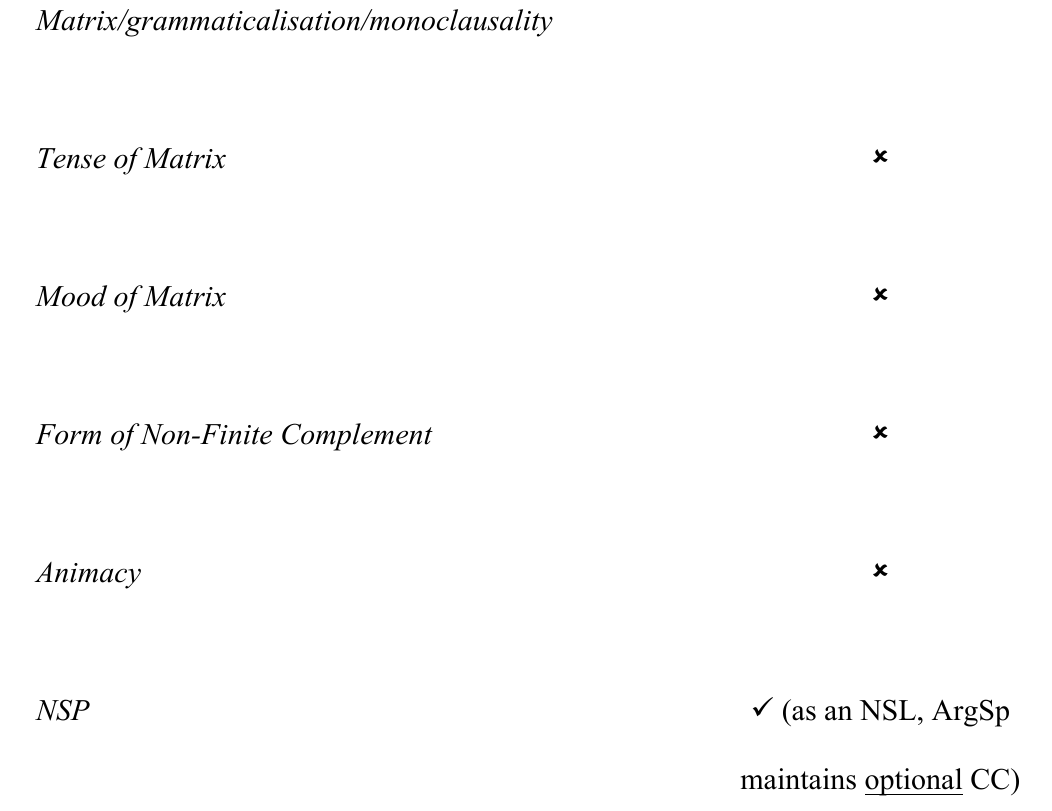
Table 5 . Summary of which internal variables can be deemed a trigger for CC